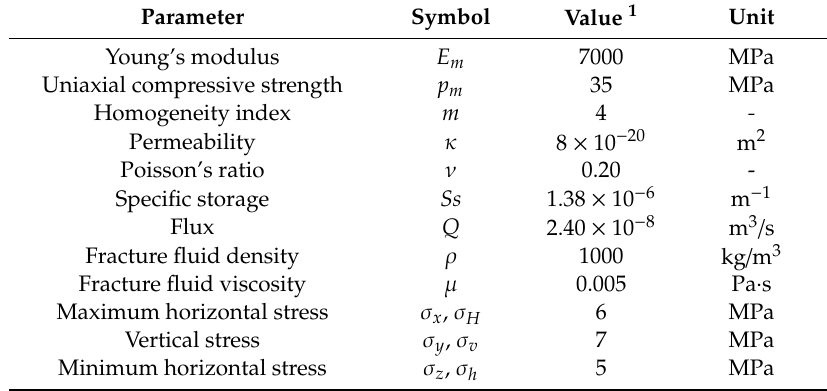
Table 1. Material parameters and boundary conditions of the simulated “single completion” model in